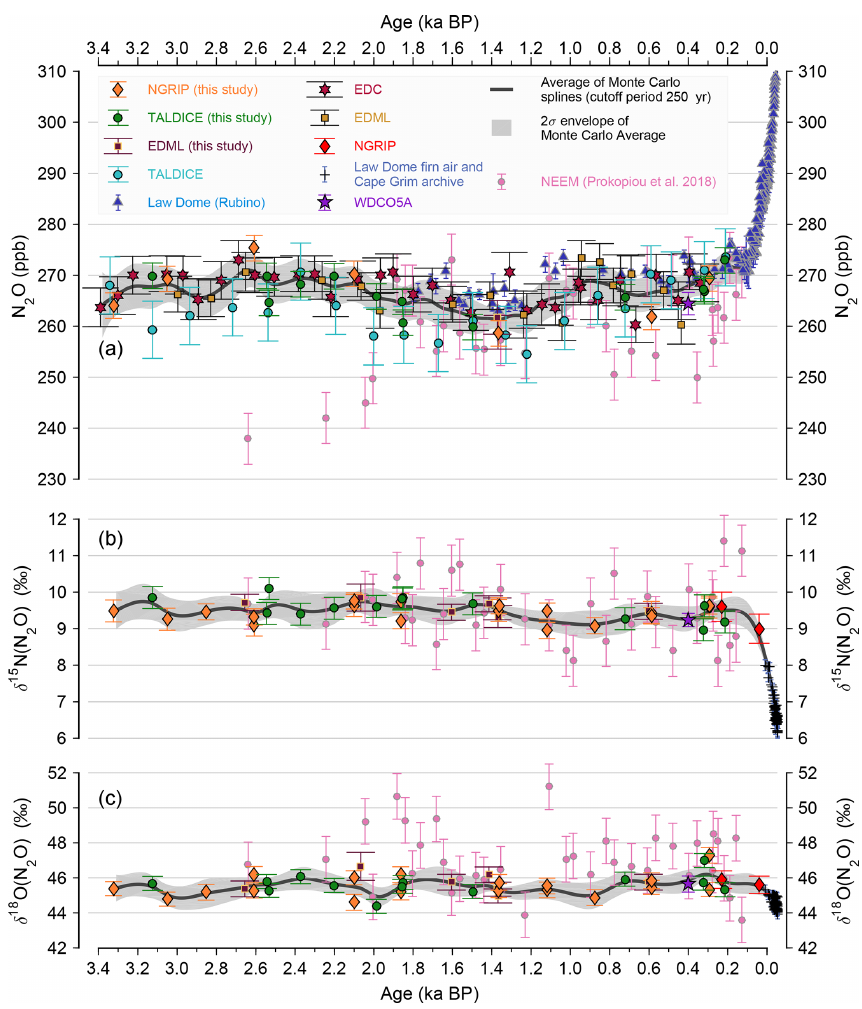
Figure 4. Late Holocene evolution of (a) N 2 O concentrations from this study and published records (Bernard et al., 2006; Flückiger et al., 2002; MacFarling Meure et al., 2006; Park et al., 2012; Schilt et al., 2010b; Schmitt et al., 2014; Rubino et al., 2019; Prokopiou et al., 2018) (b) δ 15 N(N 2 O) and (c) δ 18 O(N 2 O) from this study and published records (Bernard et al., 2006; Park et al., 2012; Schmitt et al., 2014; Prokopiou et al., 2018), connecting the ice core records and the independent reconstructions using firn air and the Cape Grim air archive (Park et al.,